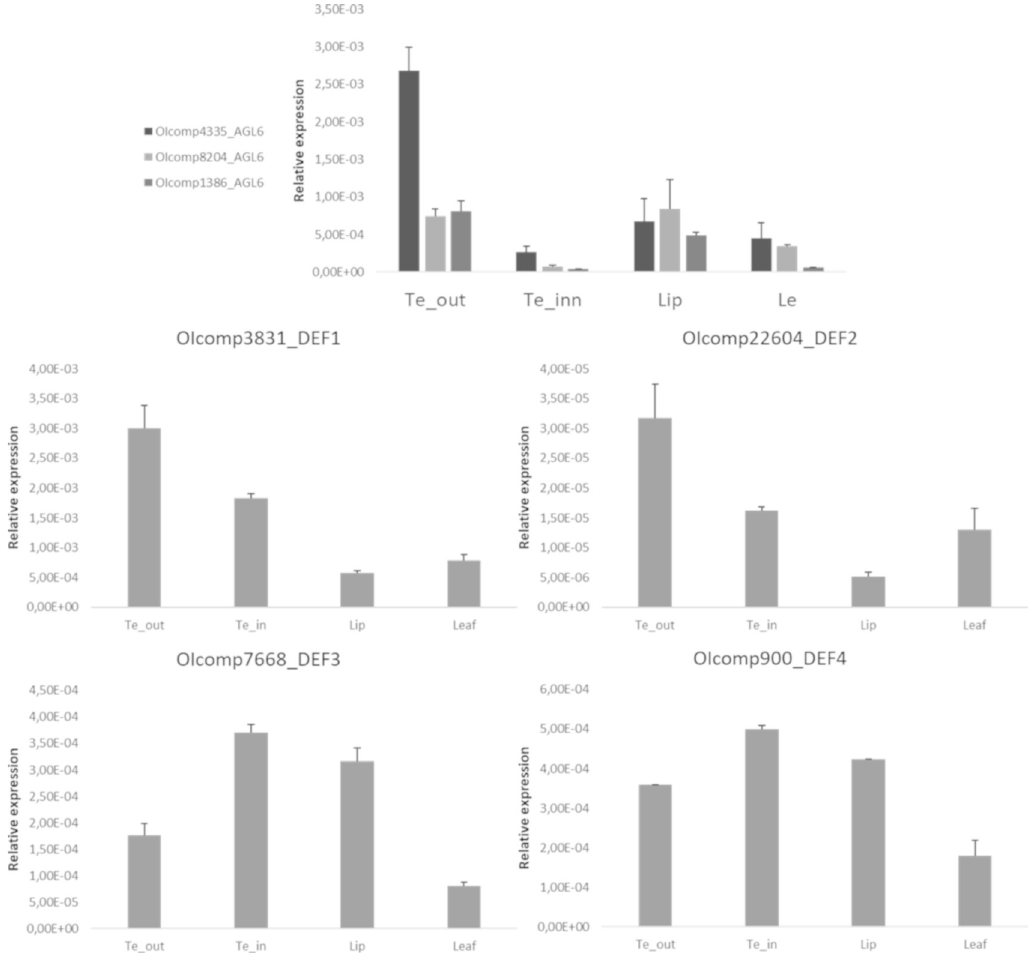
Fig 7. Expression pattern of the AGL6 and AP3/DEF MADS-box genes in the perianth of O . italica . Each column of the AGL6 genes indicates the relative expression of 10 floral organs in two cDNA pools (10 floral organs from two different plants), both of which are amplified in triplicate. The error bars represent the standard error of the mean. Te_out, outer tepals; Te_inn, inner tepals; Le,